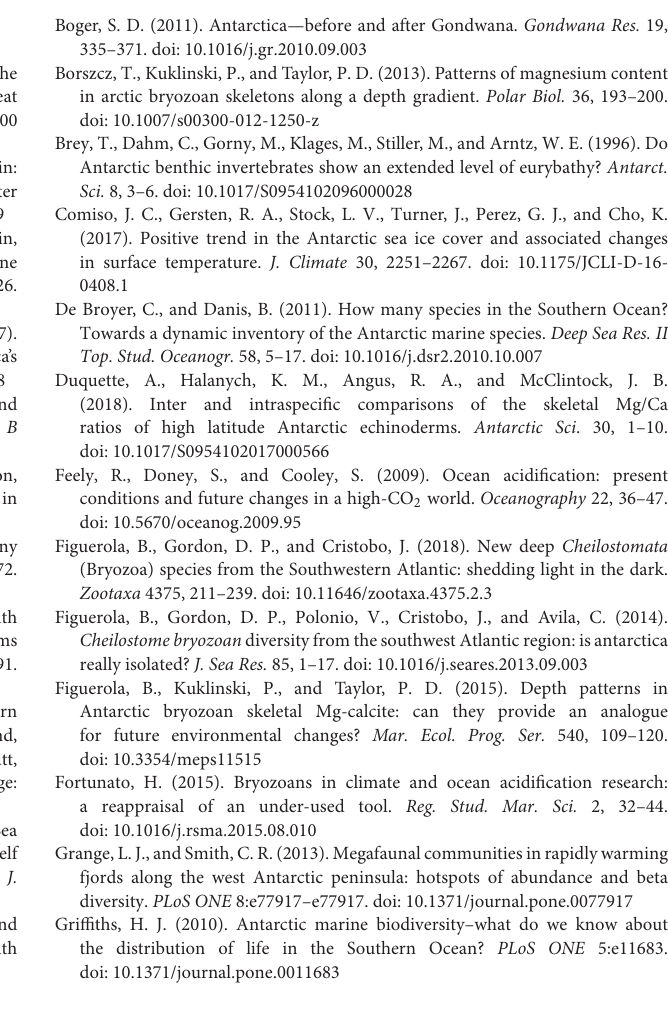
genera are listed from top to bottom in the left panel. Across each panel the middle image is a scanning electron micrograph of the mineralized skeleton with the tissues removed. The right panel is an image taken from our seabed imaging dataset that corresponds to the particular bryozoan group or genus. Supplemental Table 1 | Bryozoan species records gathered from external